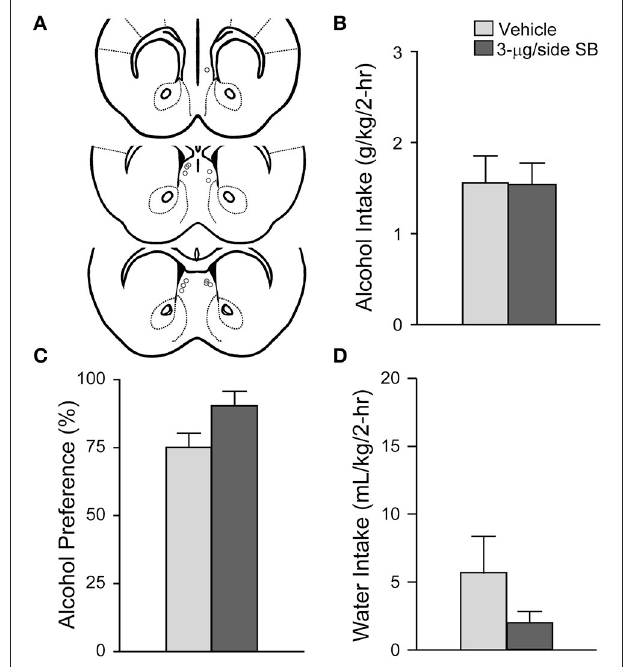
FIGURE 3 | OX2R blockade within the mNAsh did not reduce alcohol drinking. (A) Locations of cannulae, as for Figure 1 . (B–D) Infusion of 3- µ g TCS within the mNAsh did not alter (B) alcohol intake, (C) preference, or (D) concurrent water intake.